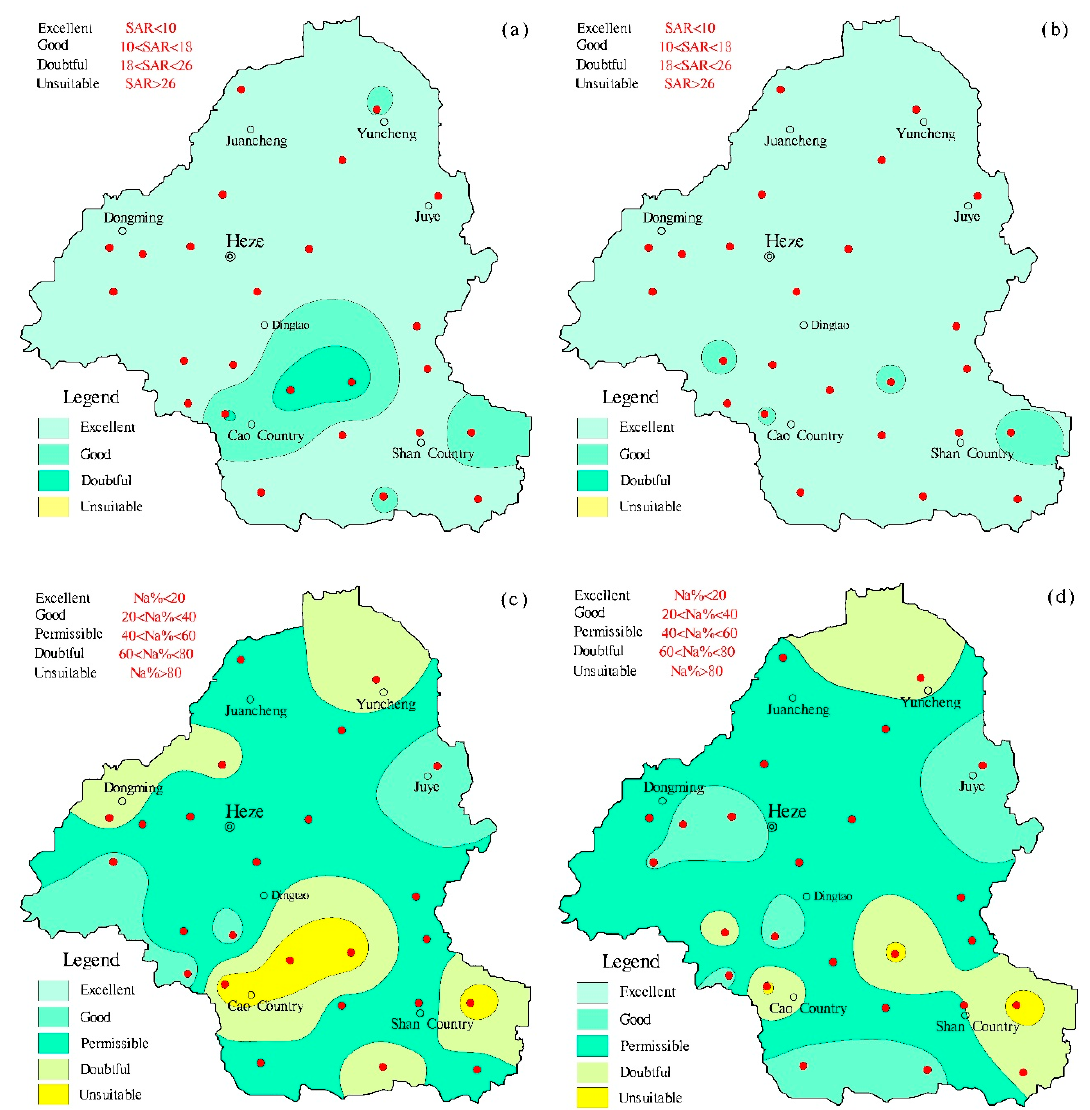
Figure 11. Distributed map of SAR and % Na: ( a ) SAR in 2016, ( b ) SAR in 2017, ( c ) % Na in 2016 and ( d ) % Na in2017.